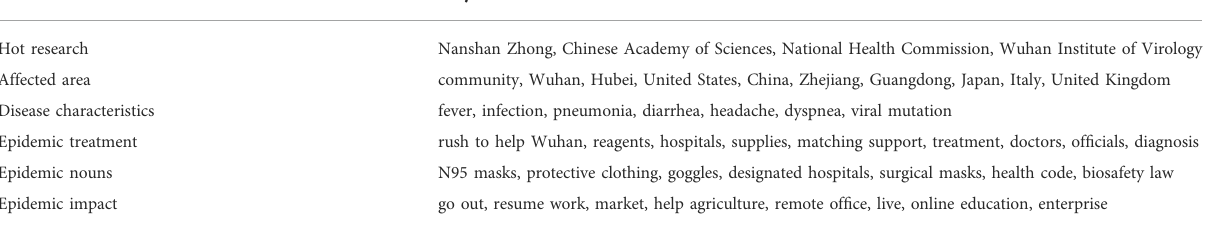
TABLE 1 The themes and their key